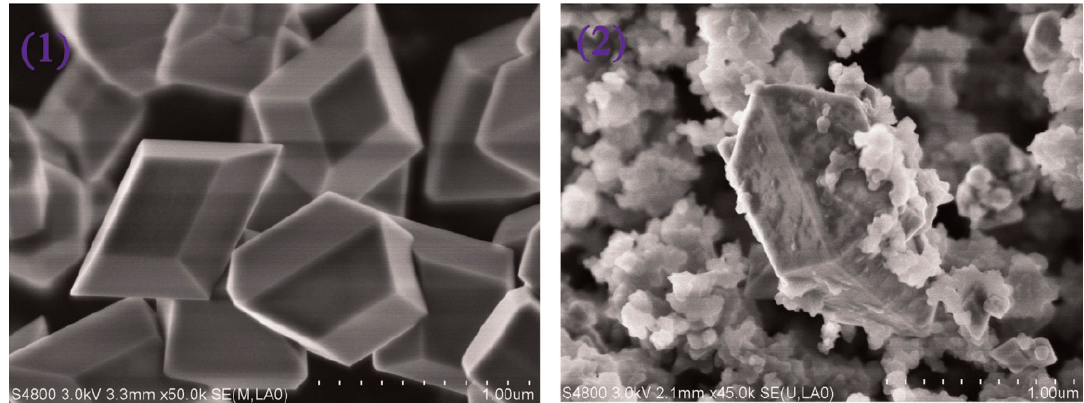
Figure 5. Scanning electron microscope (SEM) structure images of ( 1 ) upconverting particles (UCPs), and ( 2 ) MIPs@UCPs. Reprinted with permission from [74], copyright (2015) Elsevier.